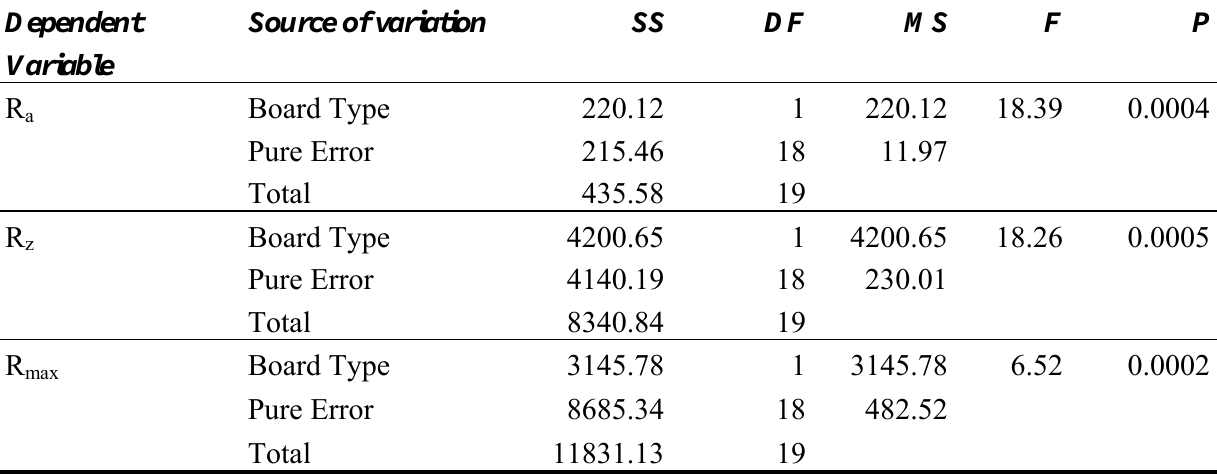
Table 4 . Analysis of variance (ANOVA) for surface properties (R based wood plastic